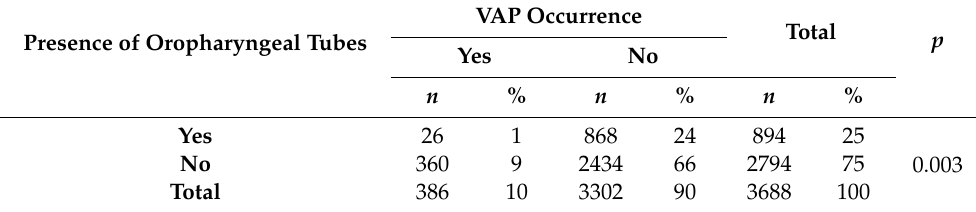
Table 3. The occurrence of VAP vs. the presence of an oropharyngeal tube in intubated patients. VAP Occurrence Presence of Oropharyngeal Tubes